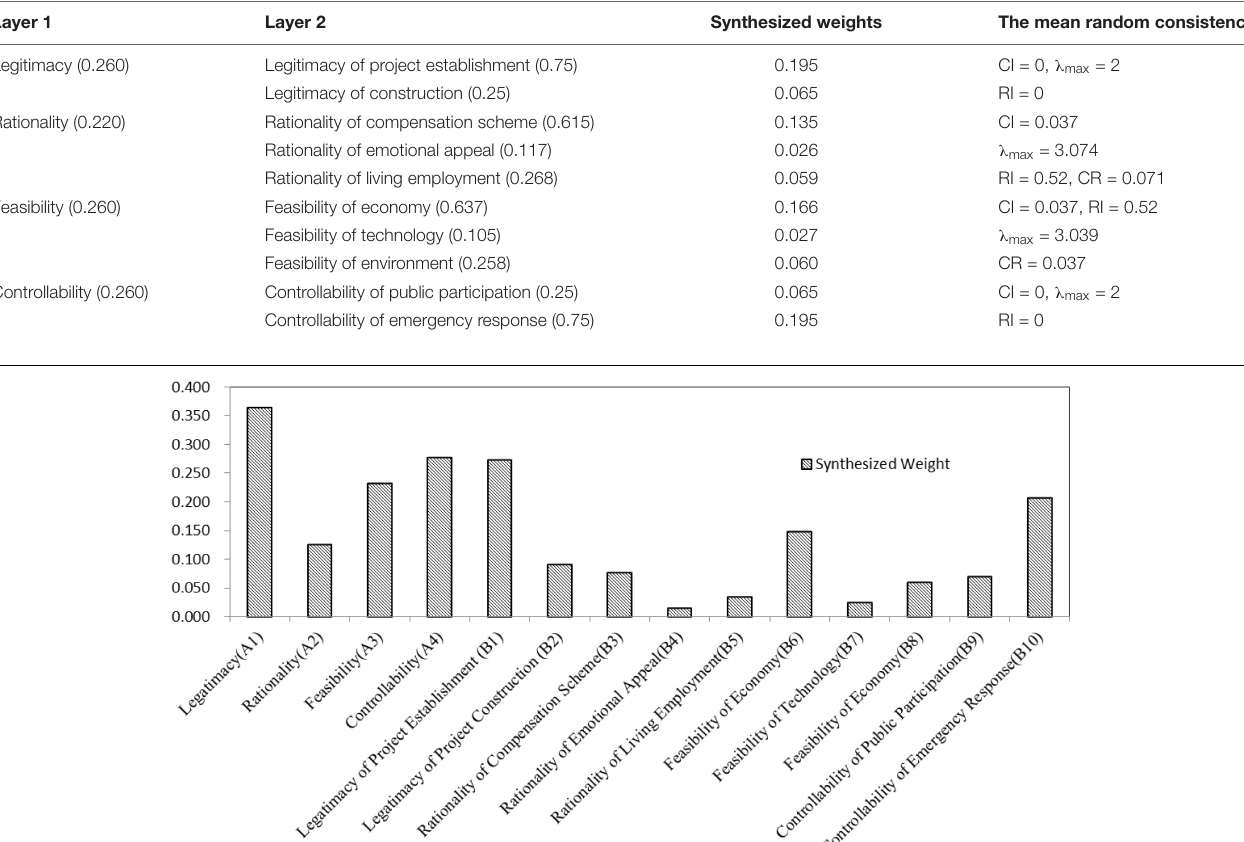
TABLE 2 | Weights of factors in layers 1–2.